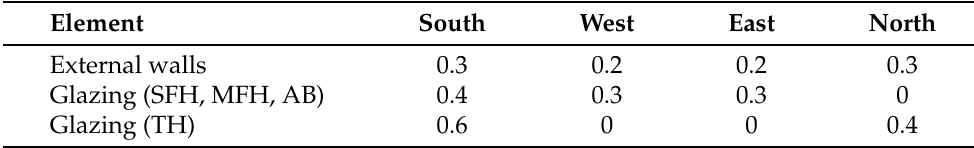
Table 2: Fraction of vertical elements exposed to South, West, East and